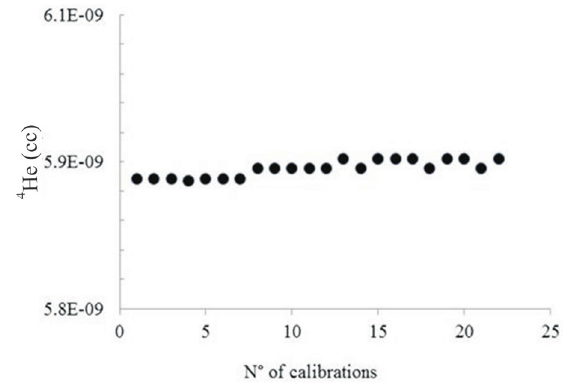
Figure 2 - the results of repeated measurements of the 4 he calibration standard.